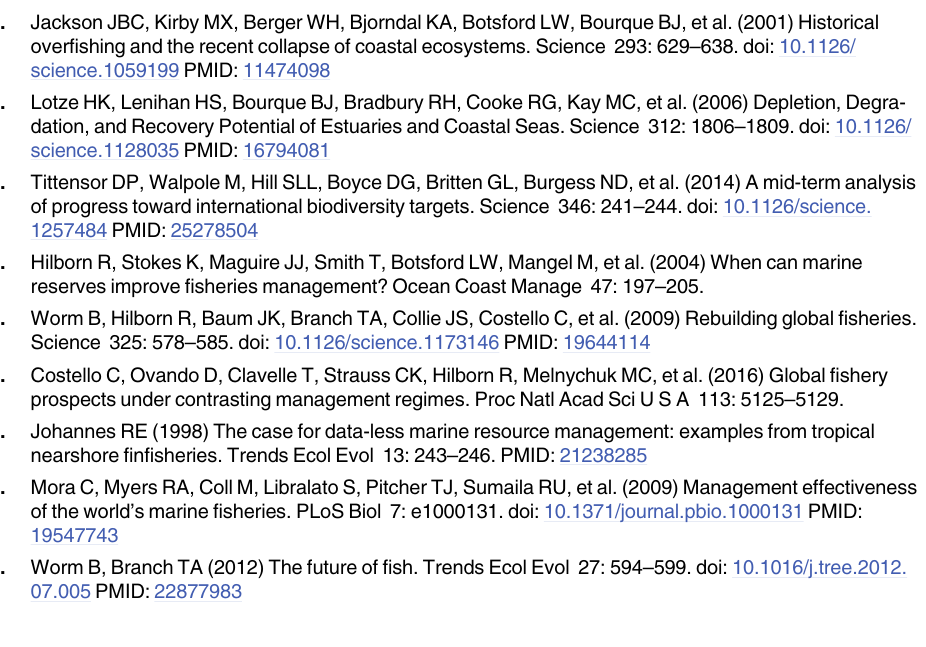
Fig 1. The two Keppel islands scenarios were run using both the spatially-implicit and spa- tially-explicit version of our